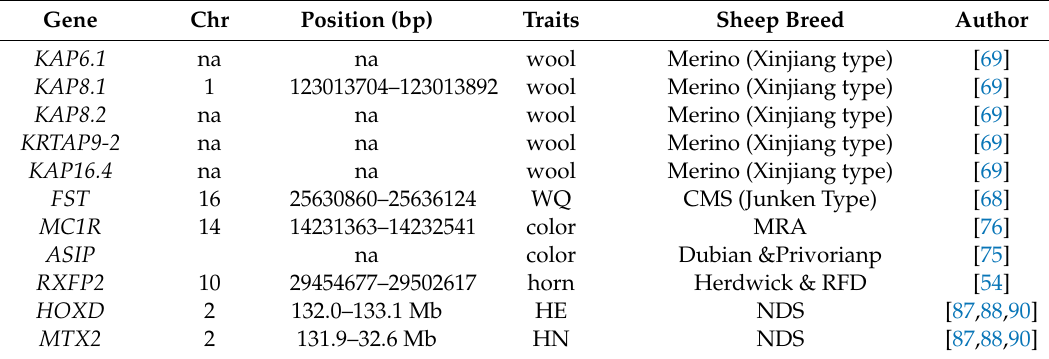
Table 5. Description and chromosomal location of genes associated with wool and coat color traits. Gene Chr Traits Sheep